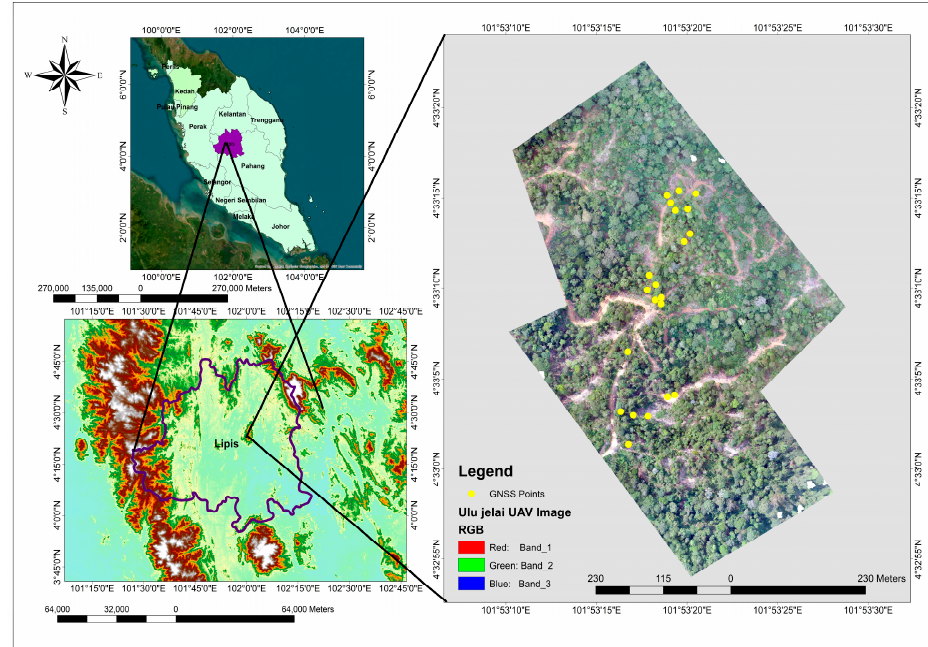
Figure 1. Map of the study area (UJFR), Pahang, Malaysia, with a close-up of Lipis District and distribution of sampling points in the research area.